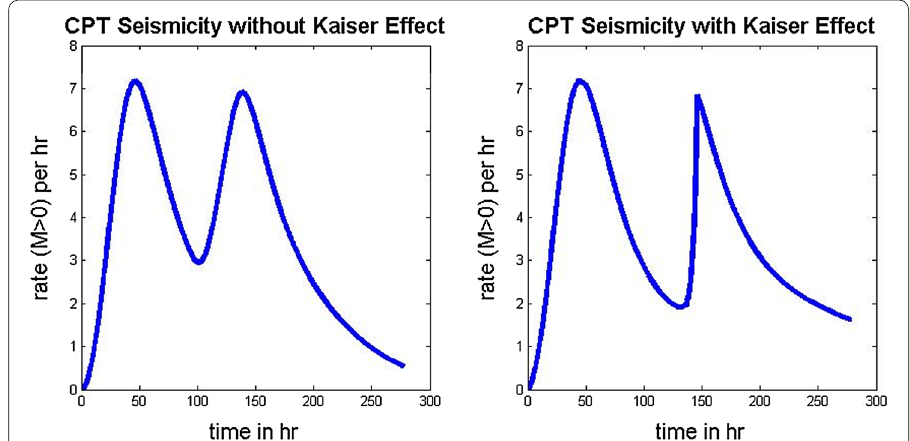
Fig. 2 Left Seismicity evolution with CPT ignoring the Kaiser effect. Note that it shows almost identical periodicity as the injection pressure. Right Seismicity evolution with CPT and considering the Kaiser effect. The early (until 80 h) and late (after 150 h) seismicity is not affected by the Kaiser effect, contrary to the time between 80 and 150